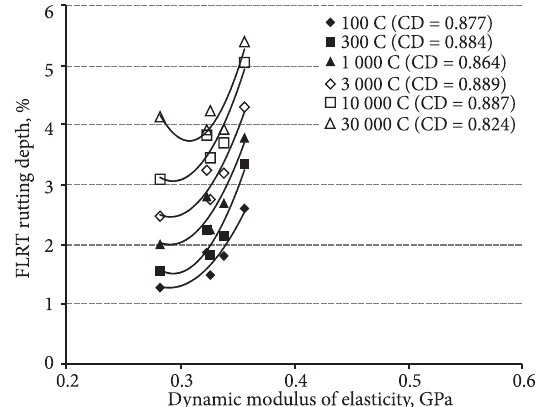
Fig. 8. Good relationships between dynamic modulus and FLRT rutting depth ( f = 0.1 Hz, T = +37.8 o